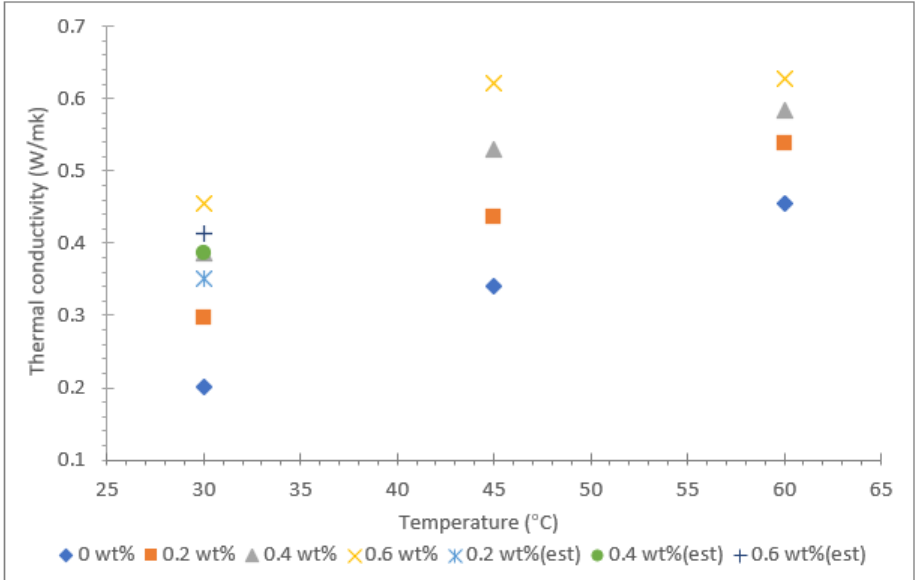
Figure 7. Thermal conductivity of coconut oil/Al 2 O 3 -TiO 2 hybrid nanofluid.